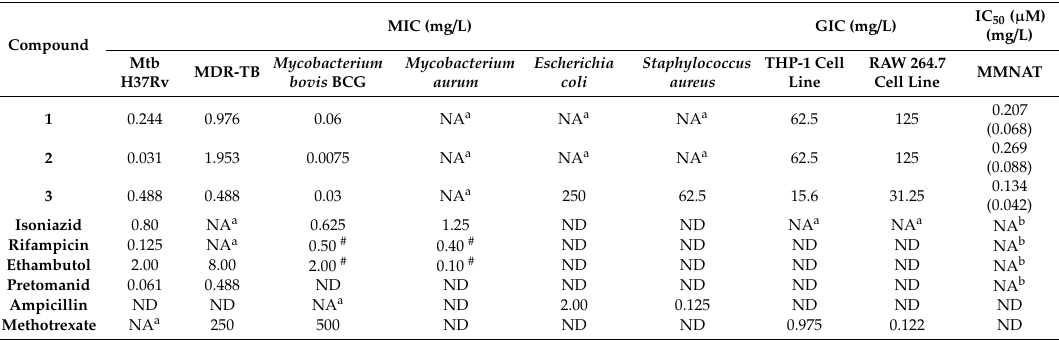
Table 1. Minimum inhibitory concentrations (MICs) of the derivatives and drug standards against di ff erent species of bacteria, growth inhibitory concentrations (GICs) for cell lines and half-maximal inhibitory concentration (IC 50 ) for